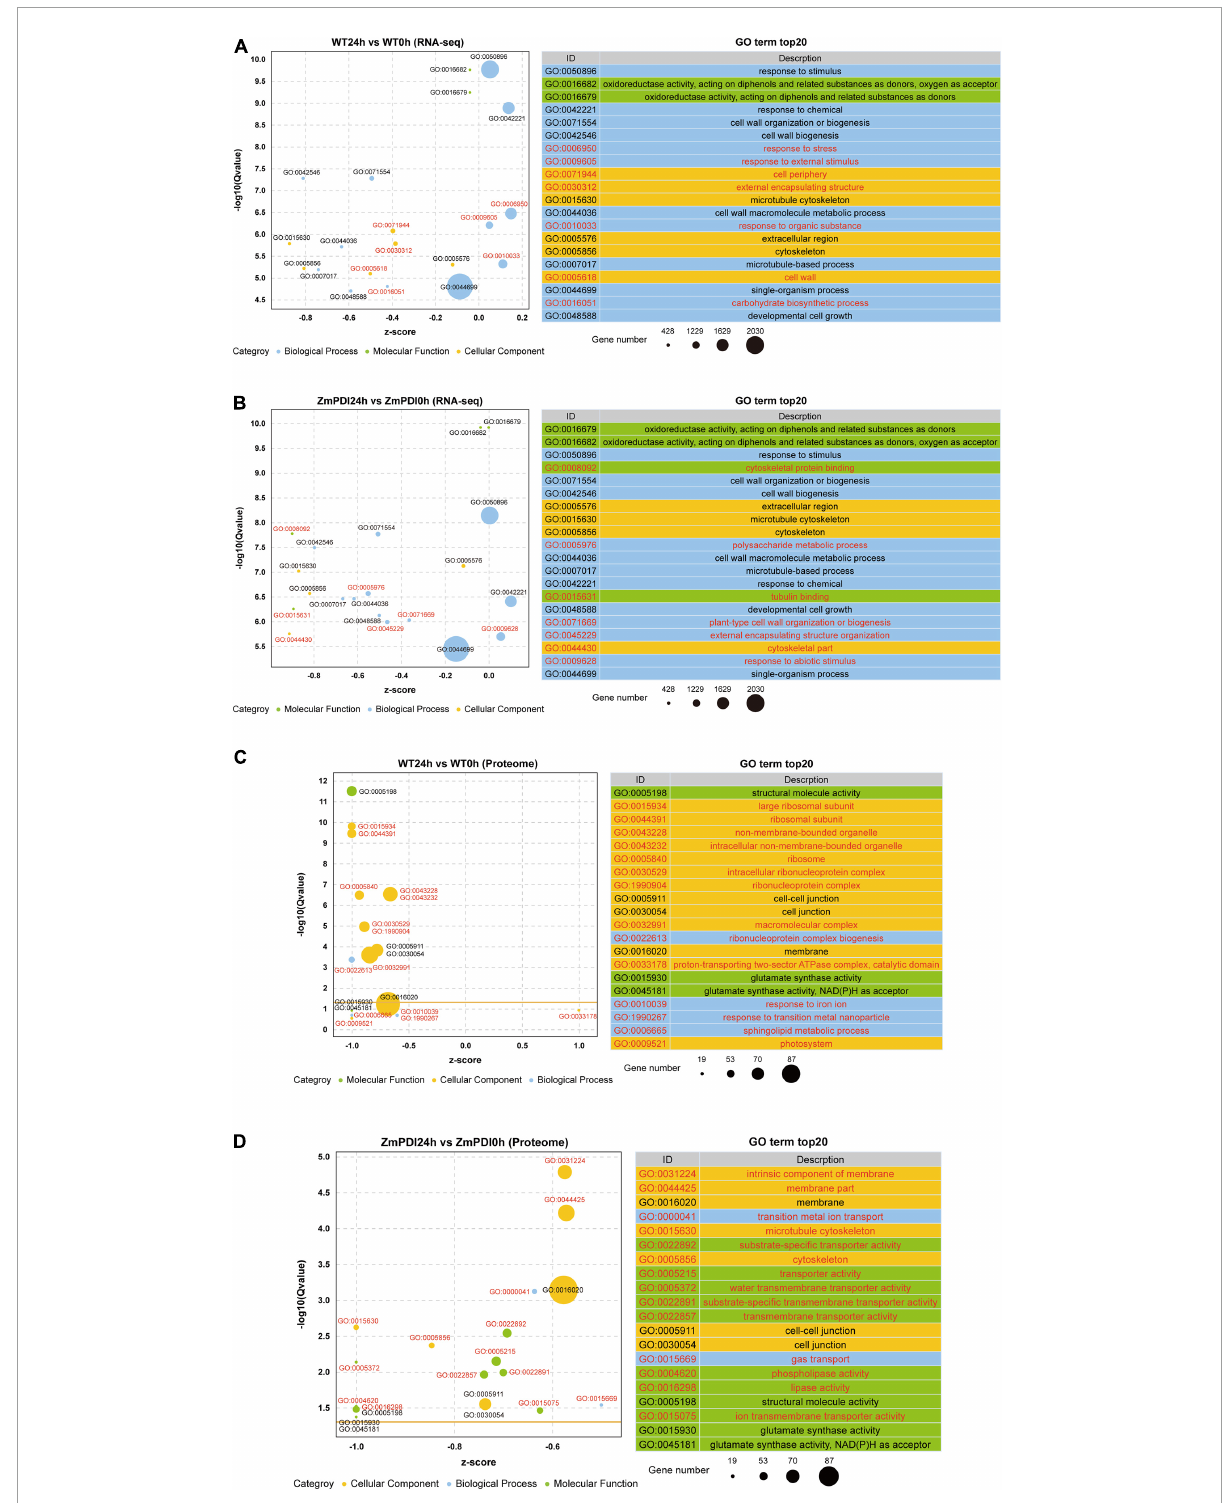
FIGURE3 Top 20 enriched GO terms of DEGs and DEPs in OX-ZmPDI transgenic and WT plants of Z. matrella . (A) Top 20 enriched GO terms of DEGs in the WT24h vs. WT0h comparison. (B) Top 20 enriched GO terms of DEGs in the ZmPDI24h vs. ZmPDI0h comparison. (C) Top 20 enriched GO terms of DEPs in the WT24h vs. WT0h comparison. (D) Top 20 enriched GO terms of DEPs in the ZmPDI24h vs. ZmPDI0h comparison. The z -score value represents the ratio of the difference between the numbers of upregulated and downregulated genes to the total number of differentially expressed genes. The yellow line represents the threshold of Q -value =